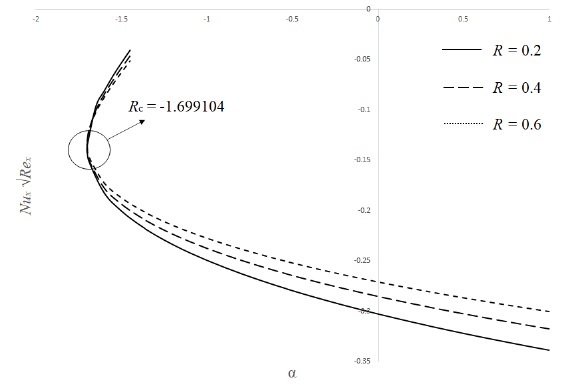
Figure 4. Local Nusselt number Nu x Re − 1/2 x for Al 2 O 3 –Cu/water with R and α .